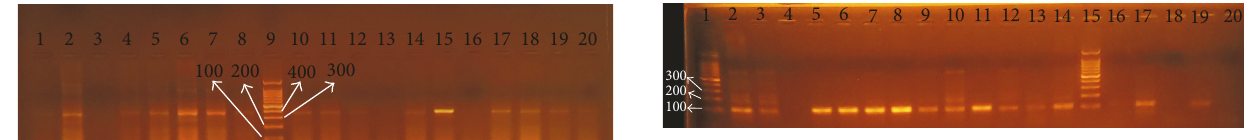
Figure 2: PCR products for H. pylori with cagA gene-based primers. The product size is 400 bp. Lane 9 is a ladder. Lanes 1–8 and 10–20 are patients’ biopsy samples.